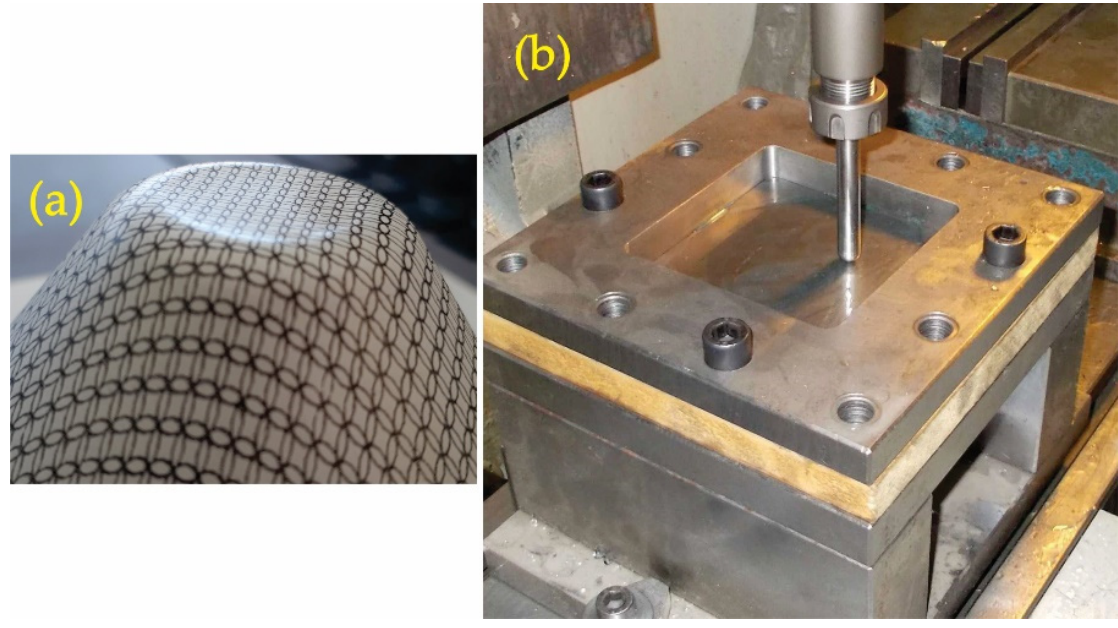
Figure 1. Bottom pillowing ( a ) (University of Ljubljana) and ( b ) tool-set (University of Novi Sad).